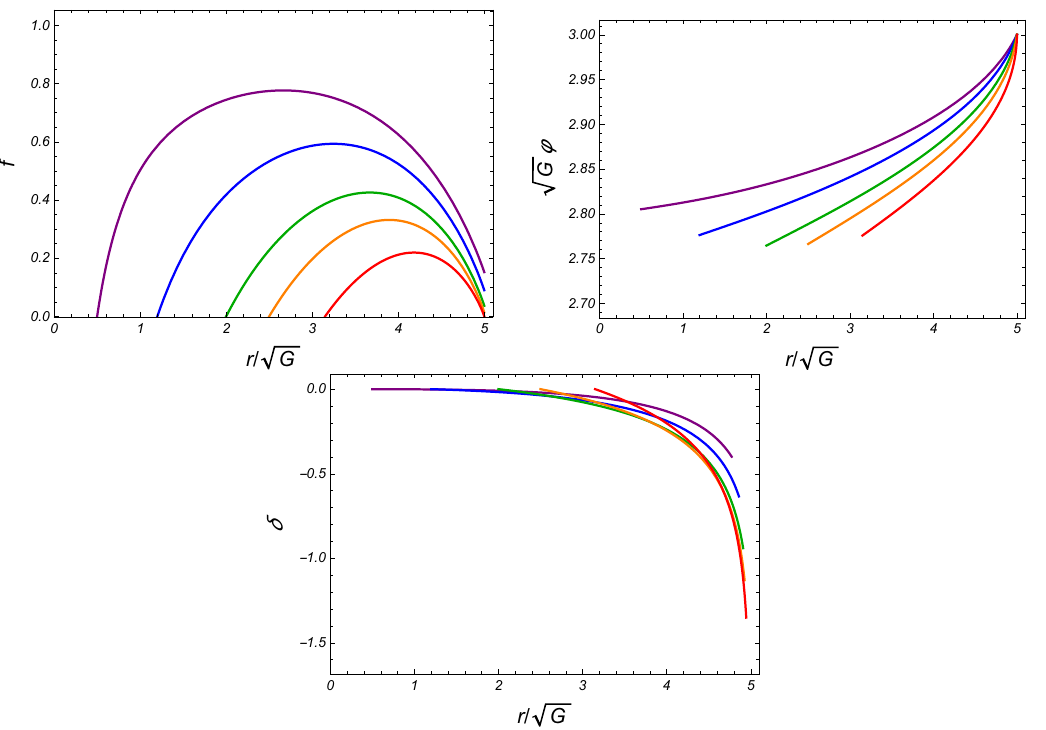
√ √ √ √ √ G, 1 . 2 G, 2 G, 2 . 5 G , and 3 . 15 G . q √ √ √ 1 − Λ r 2 . ( r = 5 1 G > G, Λ = − 0 . 04 /G, M = 0 . 1 / G ) b b 4 πG r b M